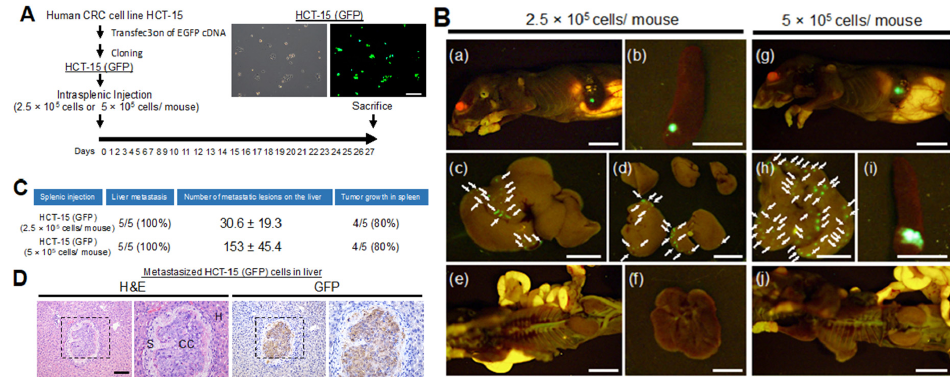
Figure 5. Characterization of a model of CRC metastasis to the liver in nude mice. ( A ) The experimental schedule. Cloned GFP-labeled HCT-15 (HCT-15-GFP) cells (2.5 × 10 5 cells or 5 × 10 5 cells suspended with Matrigel / 10 µ L) were injected into the spleens. Mice were sacrificed 27 days after the injection of cancer cells, and the livers were removed to determine the frequency of liver metastasis. ( Upper right ) The pictures of cloned HCT-15-GFP cells. Scale bar: 50 µ m. ( B ) Growth of HCT-15-GFP cells in the injected spleens and formation of metastasis in livers. A total of 2.5 × 10 5 cells ( left ) or 5 × 10 5 cells ( right ) were injected into the spleen, and images were captured after sacrifice. Representative images of body ( a , g ), spleen ( b , i ), liver ( c , d , h ), abdominal cavity ( e , j ) and lung ( f ). The arrows point to the site of metastasis. Scale bar: 10 mm. ( C ) The status of the model is shown in the table. The number of metastatic lesions in the liver is shown as means ± SEM. The frequency of liver metastasis and tumor growth in the spleen are shown in brackets. ( D ) Representative histological appearance of metastasized HCT-15-GFP cells in the liver ( left ) and immunohistochemical detection of HCT-15-GFP cells. Scale bar: 100 μ m.